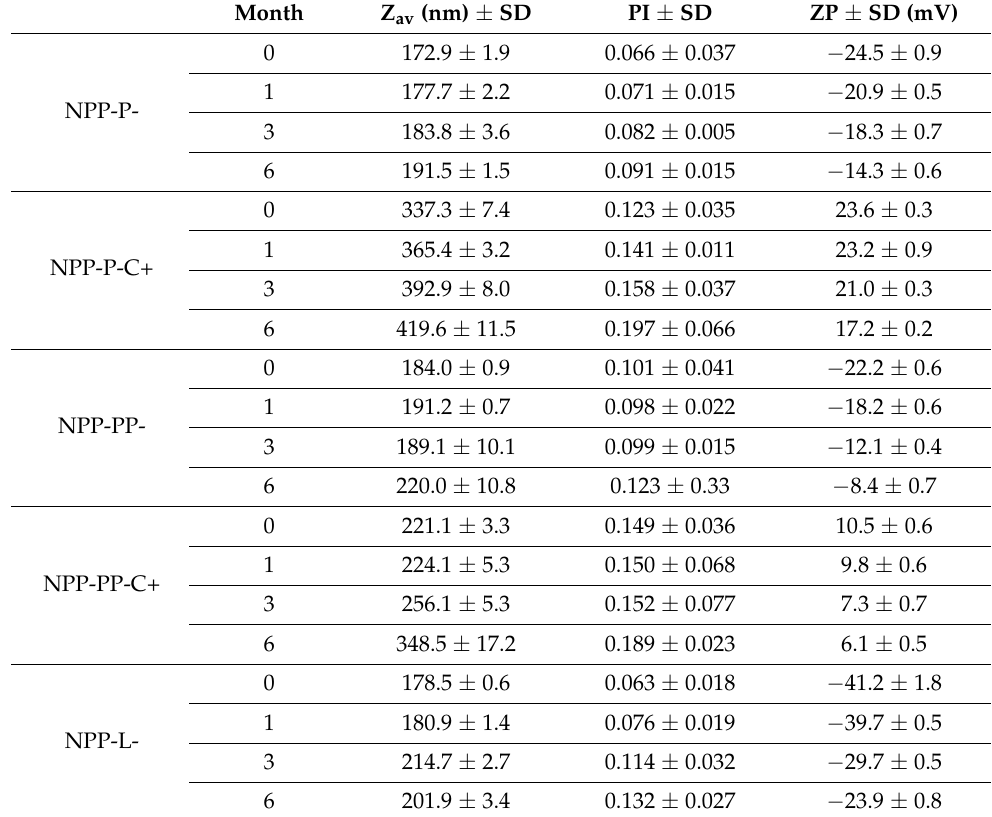
Table 2. Physicochemical values of TH-NPs with different surface functionalization stored at 4 ◦